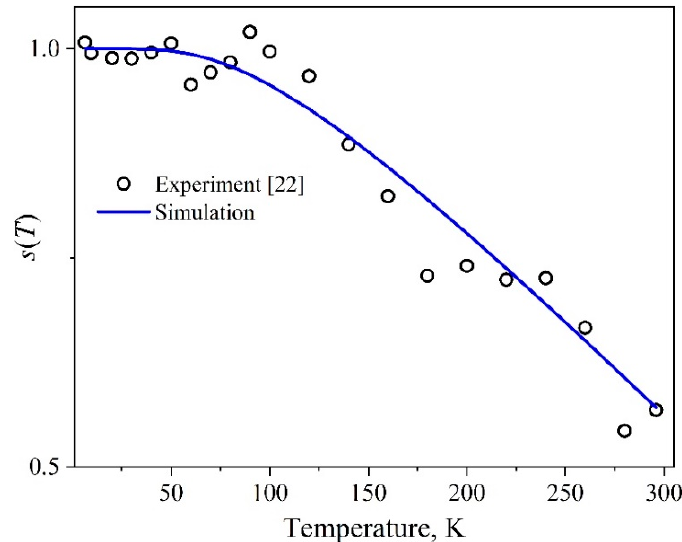
Figure4. RelativechangeintheexcitonpeakareacalculatedbytheEquation(5)forInP / Figure 4. Relative change in the exciton peak area calculated by the Equation (5) for InP/ZnS nanocrystals.